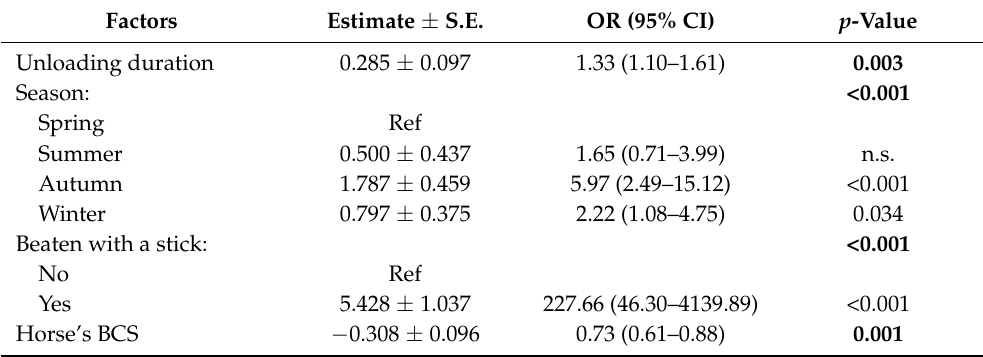
Table 9. Reluctance to move/unload—final multiple regression model for the dummy dependent variable of presence/absence of handled horses showing reluctant to move/unload behavior at arrival at the slaughterhouse. Data are presented as estimates and standard errors (S.E.) of the effect, odds ratios (OR), confidence interval (95% CI), and p -value. Bold p -values refer to the statistical significance of the predictive variable in the model; the significance of a category against the reference is reported in regular font.